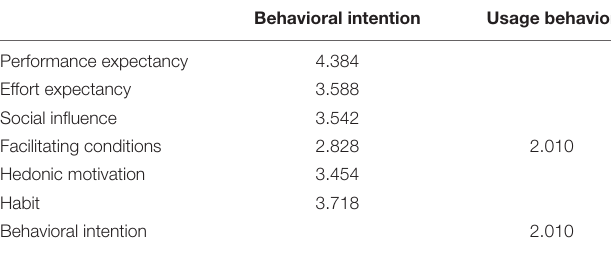
TABLE 6 | The VIF values of the internal